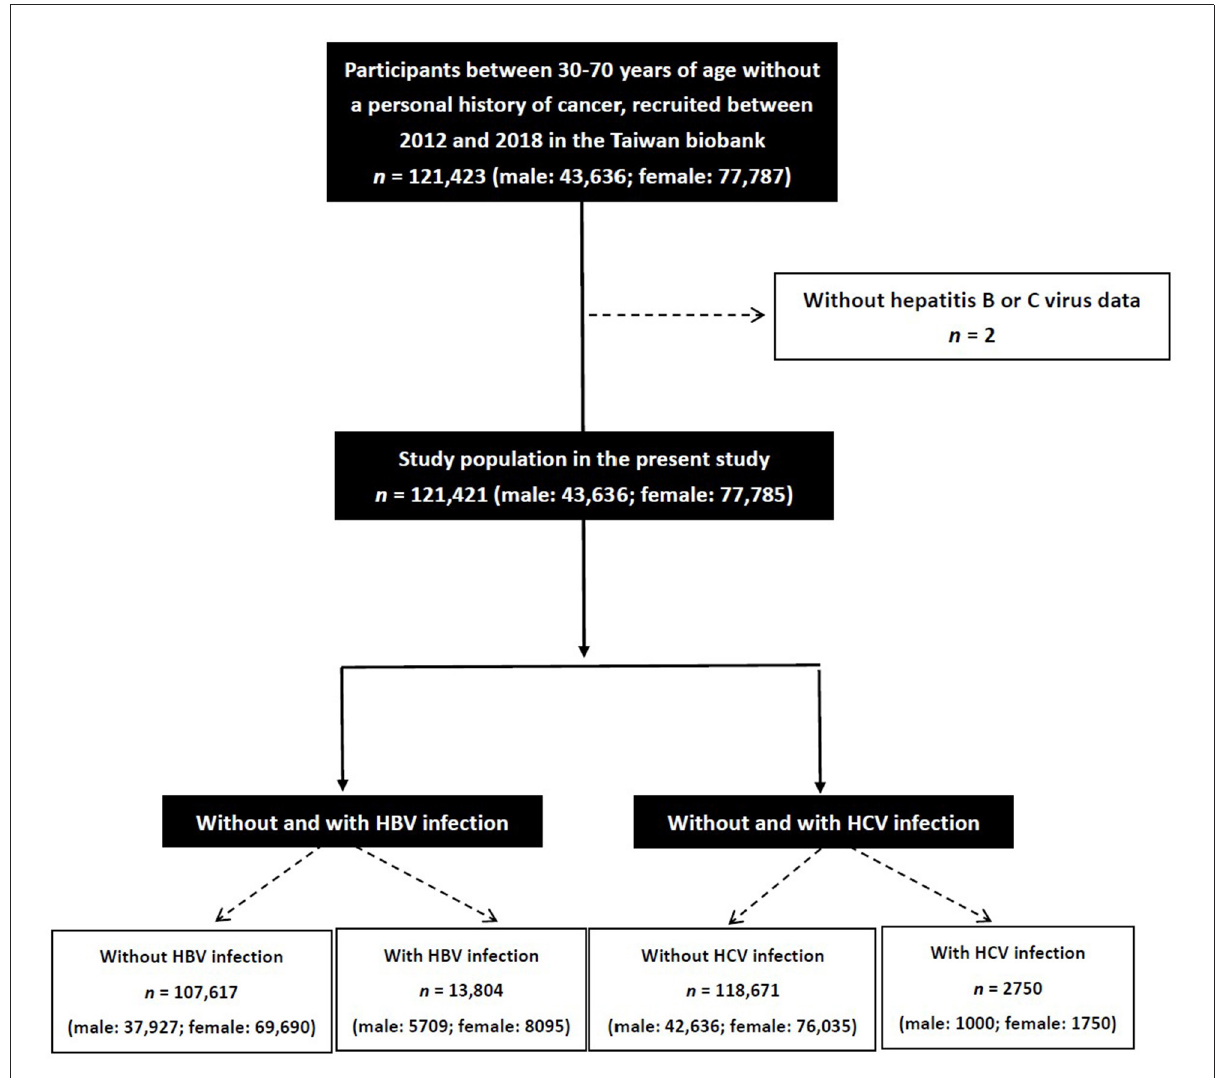
FIGURE1 Flowchart of study